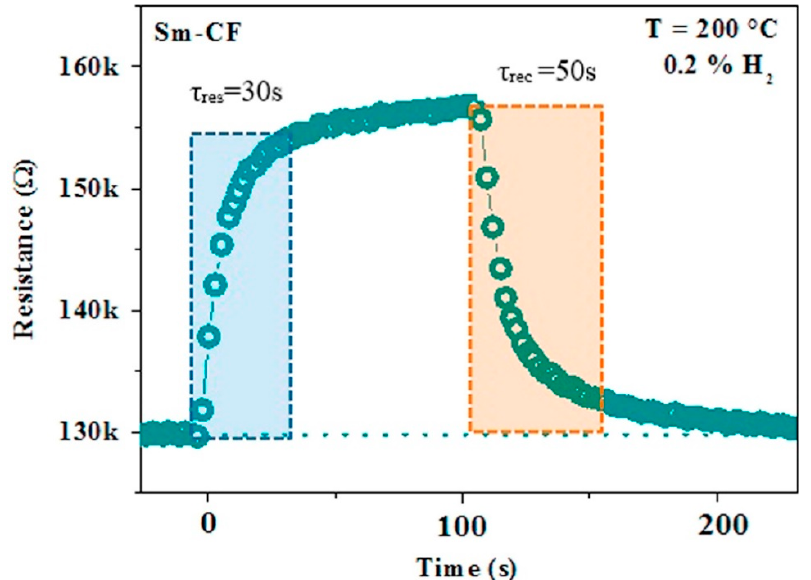
Figure 10. Transient response of the Sm-Cobalt ferrite (Sm-CF) sensor, showing the response/recovery time. Reprinted from Ceramics International, Vol 43, Falsafi F. et al., Sm-doped cobalt ferrite nanoparticles: A novel sensing material for conductometric hydrogen leak sensor, Pages No. 1029–1037, Copyright (2017), with permission from Elsevier [91].